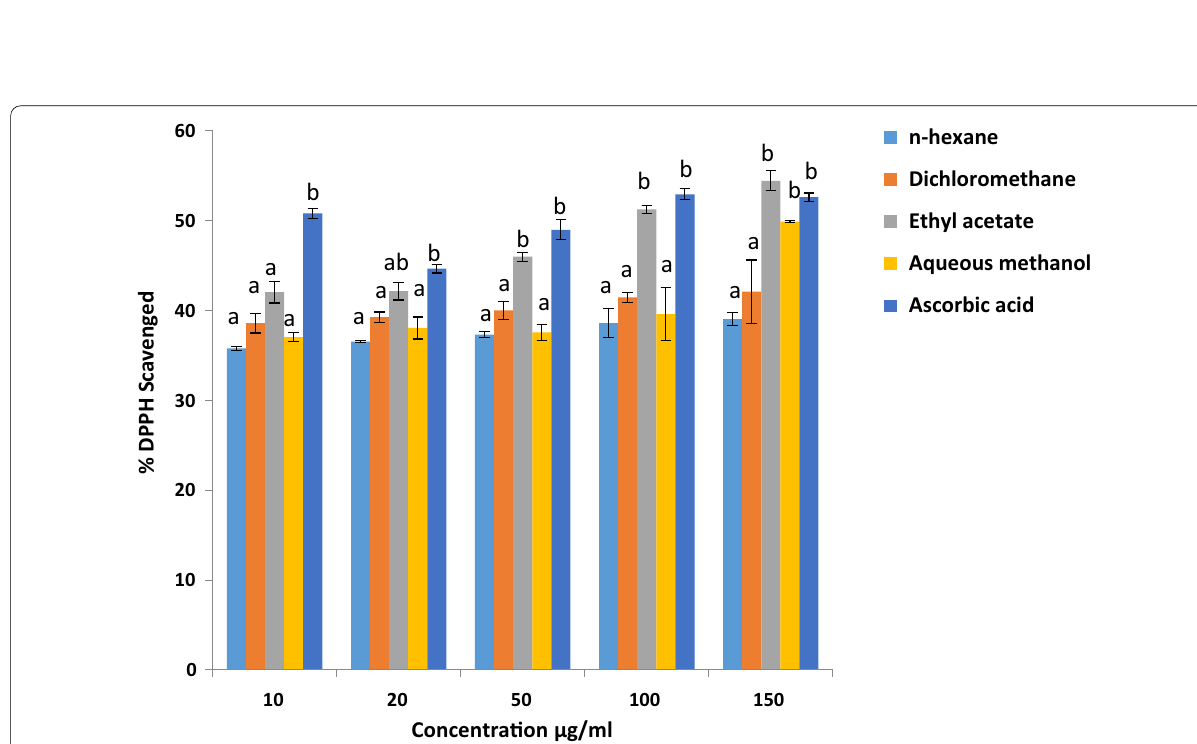
Fig. 4 DPPH radical scavenging ability of fractions from leaf extract of I. gabonensis. Values are expressed as mean on same grouped bars show that values for the fractions are significantly different ( p < 0.05) from each other. This figure shows the ability of different fractions obtained from leaf extract of I. gabonensis to scavenge DPPH radical at different